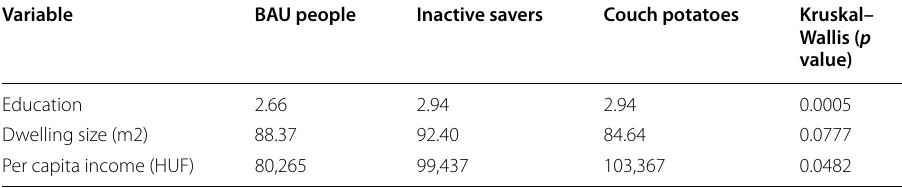
Table 5 Socio-economic profiles by cluster (only significant differences are shown) Variable